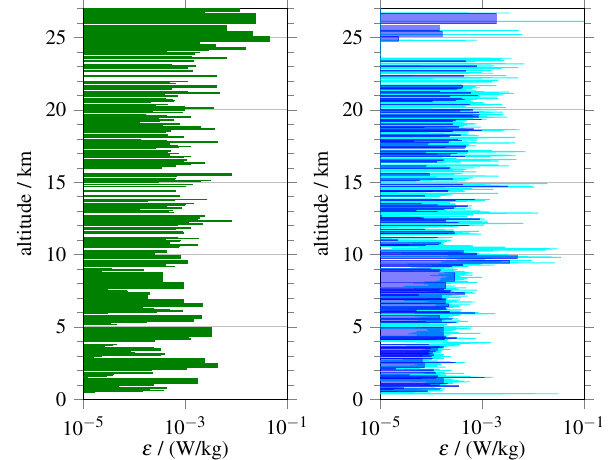
Figure 7. Energy dissipation rates from Thorpe analysis of the ra- diosonde (left) and spectral analysis of the high-resolved wind mea- surement (right) for the BEXUS 12 flight. In the right panel, the cyan curve shows ε in the full resolution, the blue bars visualise averages over the unstable layers detected by the Thorpe analysis ( (cid:104) ε (cid:105) ).